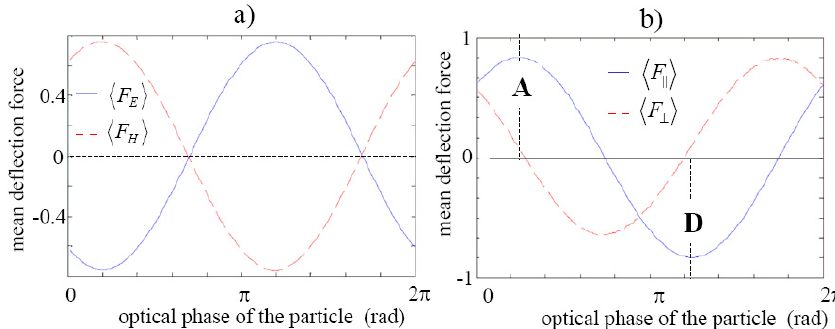
i and electric h F i mean deflection force experienced by the particle over one accelerator FIG. 6. (Color) (a) Plot of the magnetic h F H E (cid:4) 1 . Hence, the period as a function of the particle launch phase. The forces are normalized to the input plane-wave field amplitude E 0 i (cid:1) 0 : 6 means that the average amplitude of the transverse electric experienced by the particle at that optical maximum value of h F E i (cid:10) h F i and mean longitudinal force h F i versus . (b) Plot of the total transverse mean deflection force h F ? i (cid:4) h F phase is (cid:1) 0 : 6 E k H E 0 particle phase. Both curves of h F ? i and h F k i are normalized to their respective maximum values. Phase A corresponds to the maximum acceleration phase and D corresponds to maximum deceleration